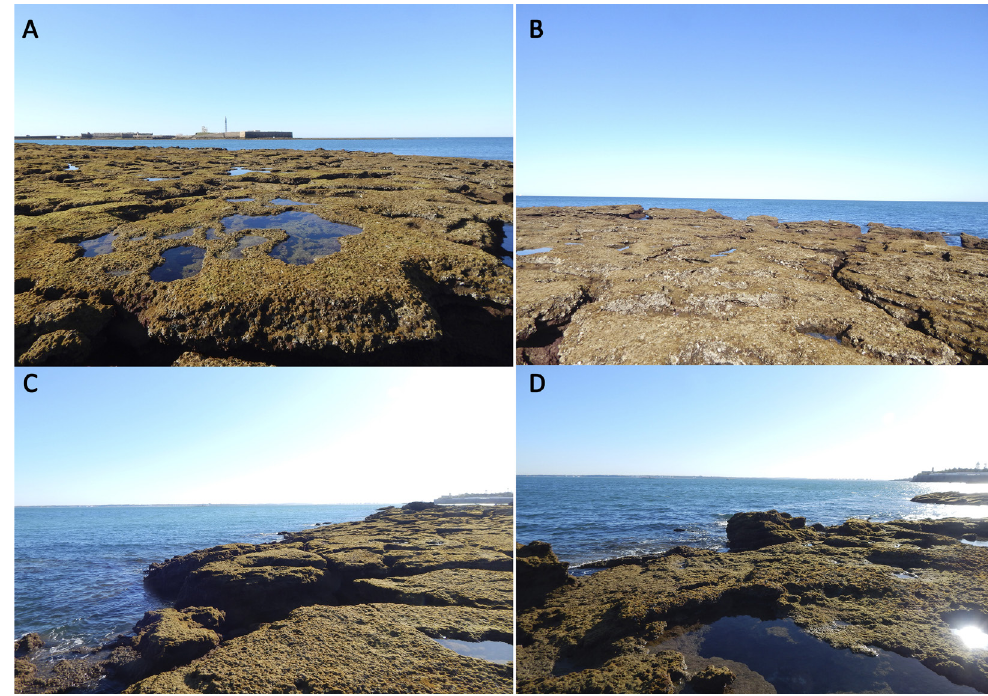
Figure 17. Experimental study from the Punta del Nao-point 1. A-B. Towards the interior of the channel and San Sebastian